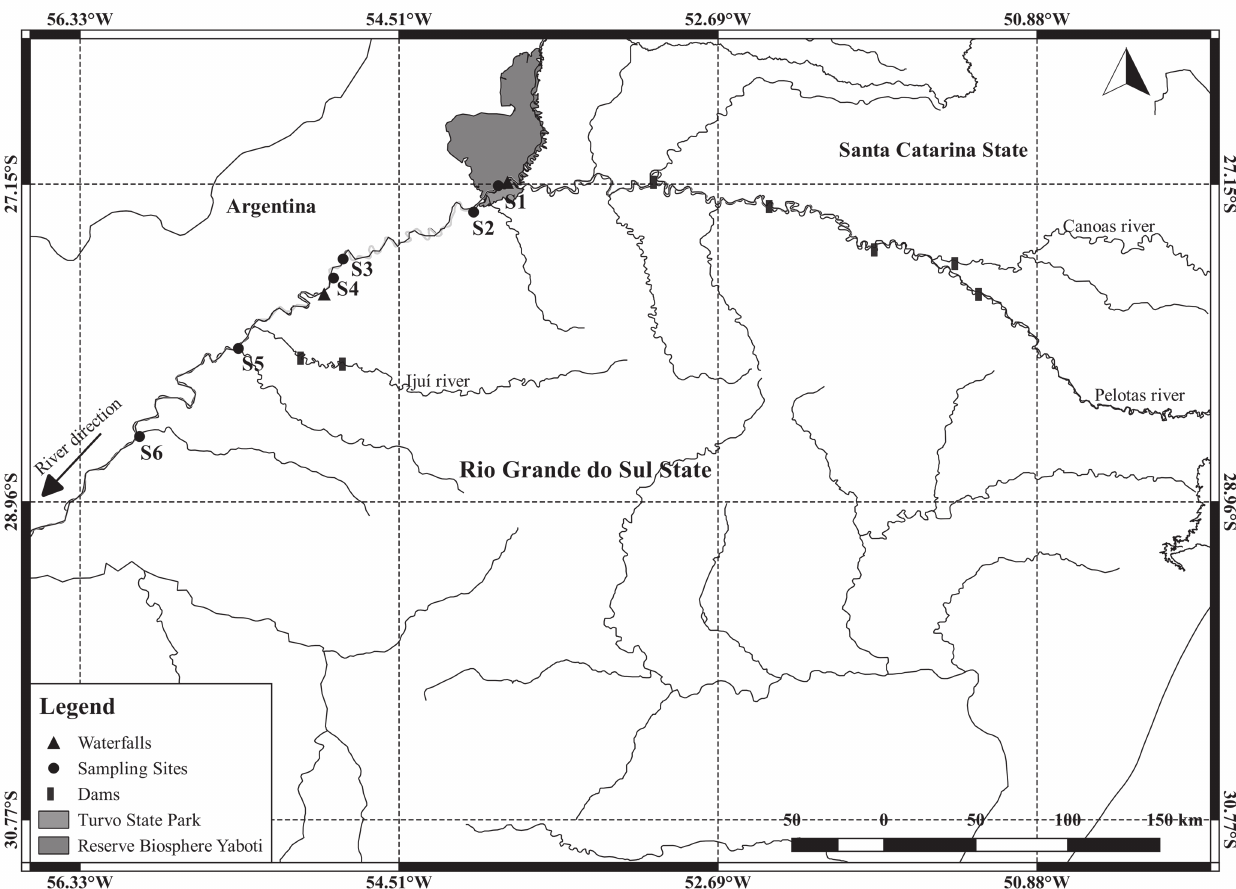
Fig. 1. Location of sampling sites along the Middle Uruguay River, RS, Brazil. Derrubadas (S1), Esperança do Sul (S2), Alecrim (S3), Porto Vera Cruz (S4), São Nicolau (S5) and São Borja (S6). Tab. 1. Information about sampling sites along the Middle Uruguay River, Brazil. *Distance from the beginning of the Middle Uruguay River Basin. **Percentage of riparian forests covering a 10 km 2 long river section. Sampling site